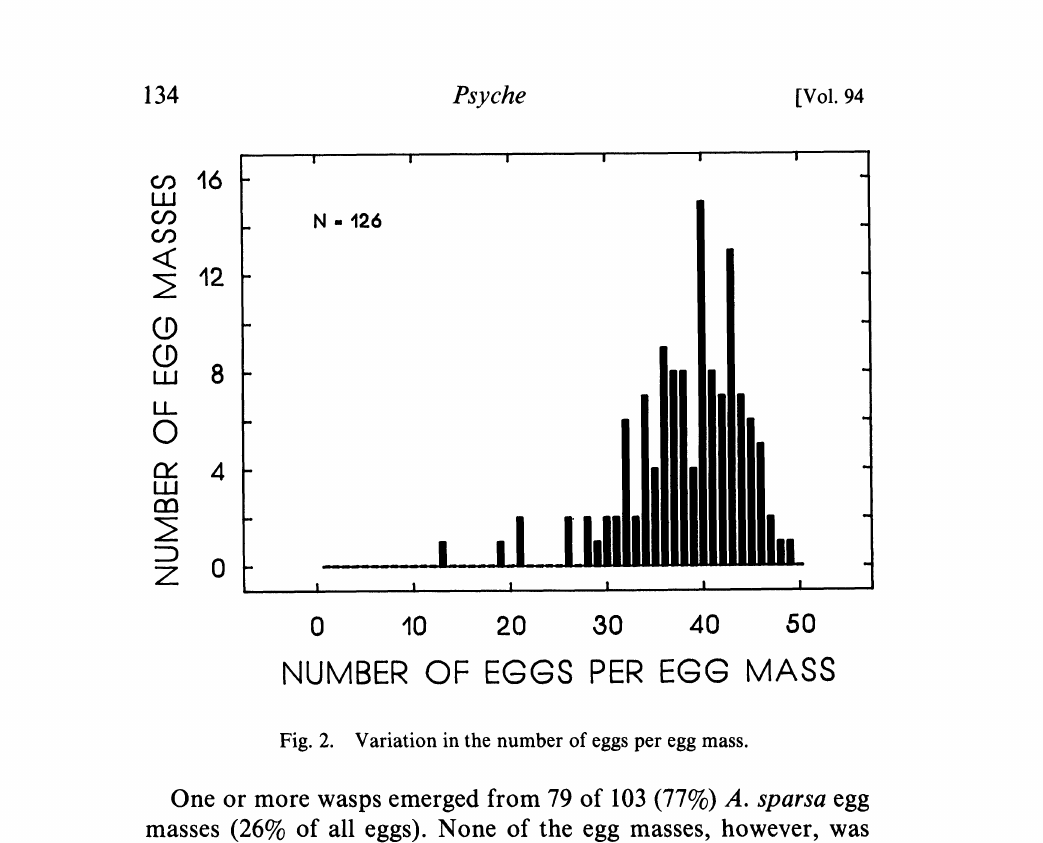
Fig. 2. Variation in the number of eggs per egg